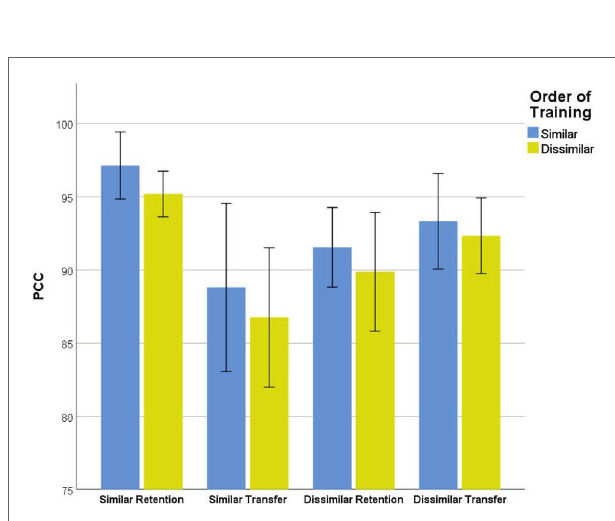
FIGURE 3 | Mean phoneme accuracy for similar and dissimilar nonwords retention and transfer blocks. Error bars - 95% CI.